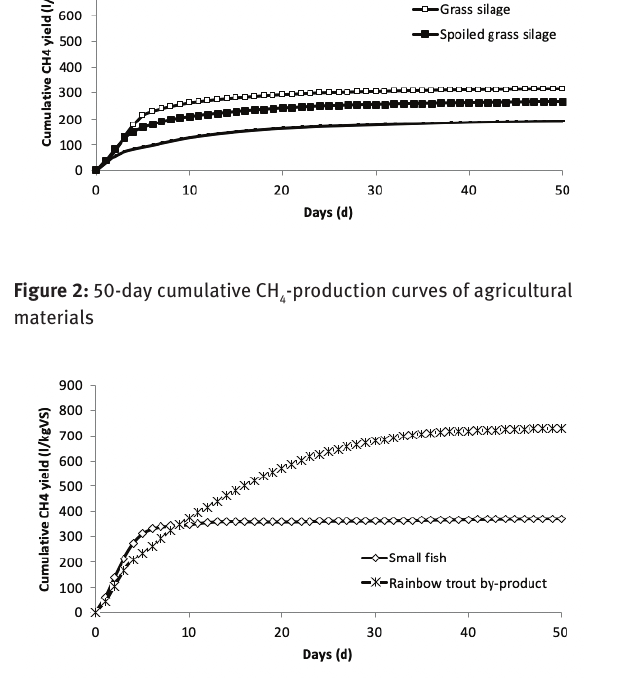
Figure 4: 50-day cumulative CH4-production curves of fish produc- tion by-products